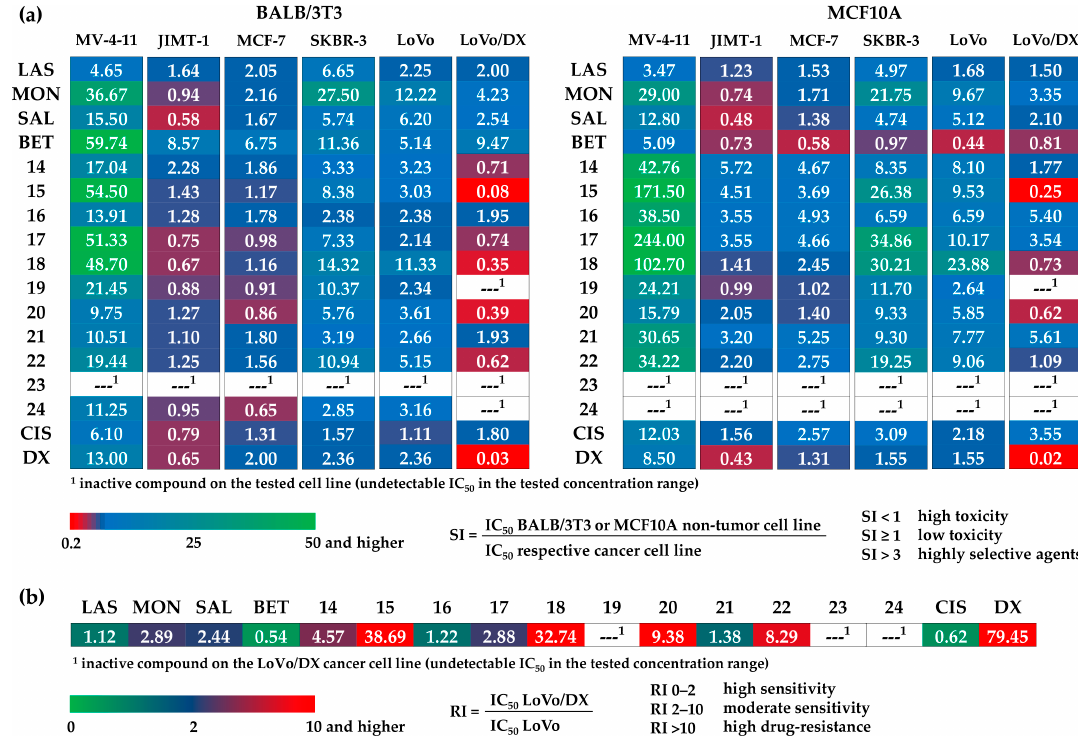
Figure 3. The calculated values of the ( a ) selectivity indexes (SI) for BALB/3T3 (left side) and MCF10A (right side) non-tumor cell lines, and ( b ) resistance indexes (RI) of the tested compounds.